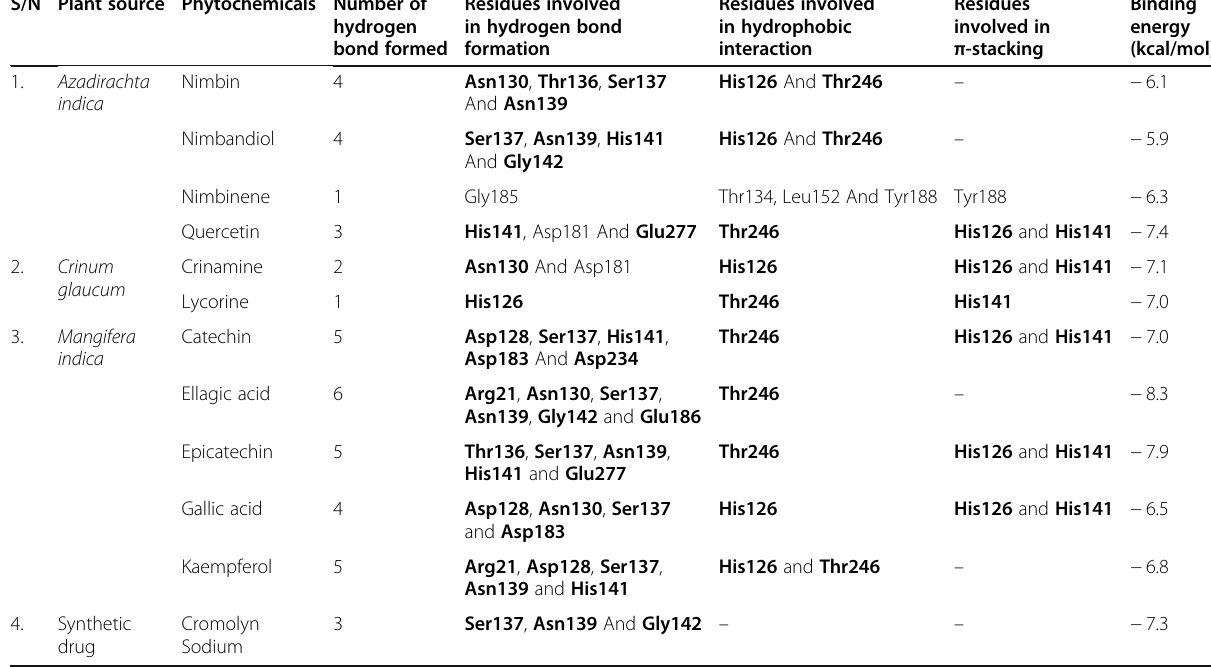
Table 4 Analysis of molecular interaction for the phytochemicals with Arginase-I S/N Plant source Phytochemicals Number of hydrogen